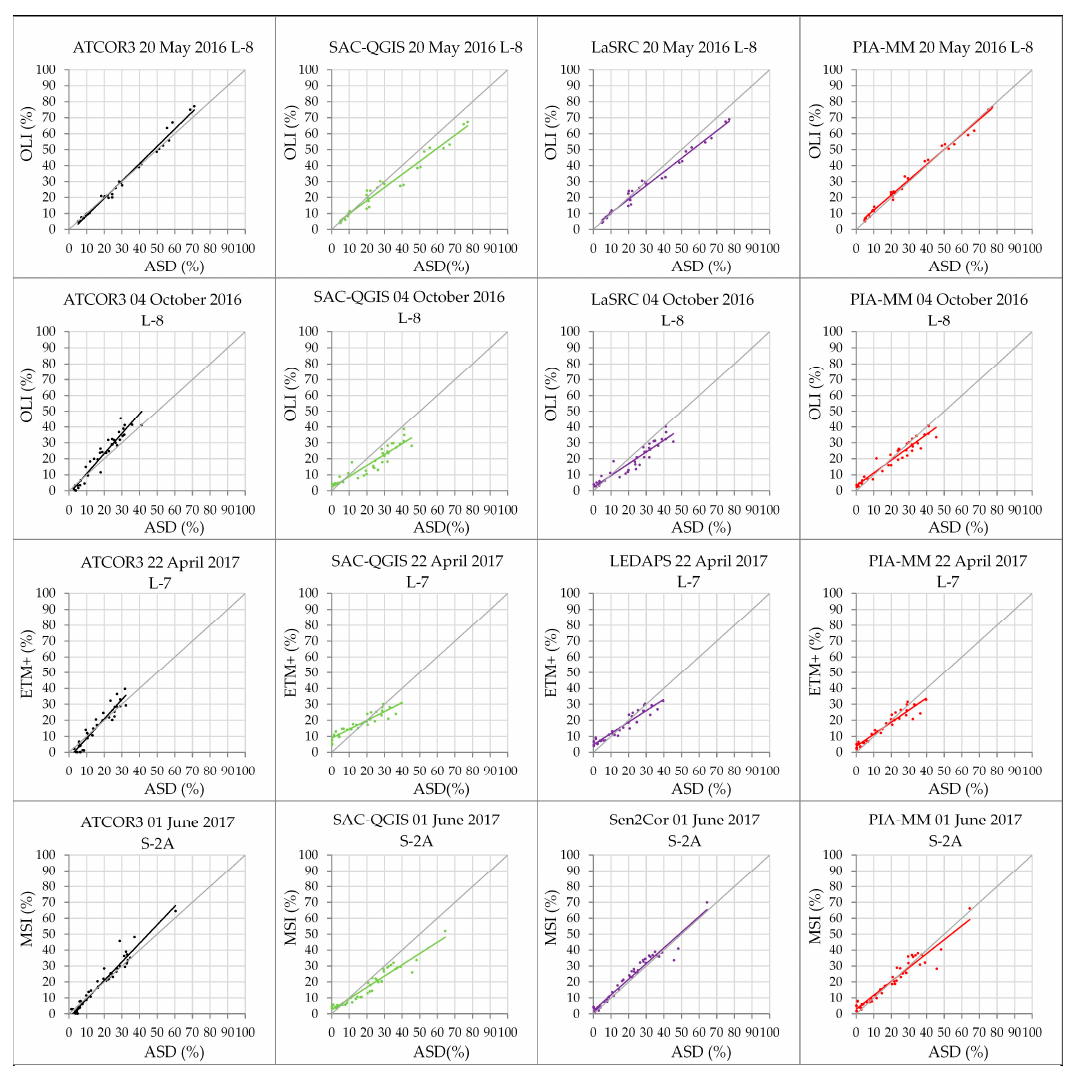
Figure 8. Scatterplots of the correlation between field measurements ( X axis) and the values of its corresponding pixel in each each Landsat atmospheric correction method ( Y axis) accounting for all bands (last column in Table 3).